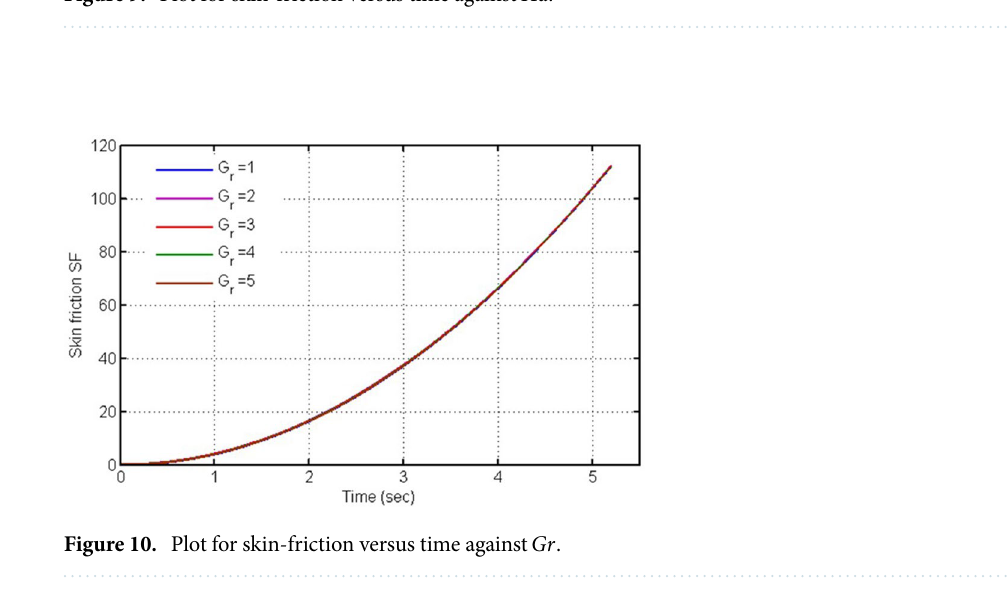
Figure 9. Plot for skin-friction versus time against Ha.